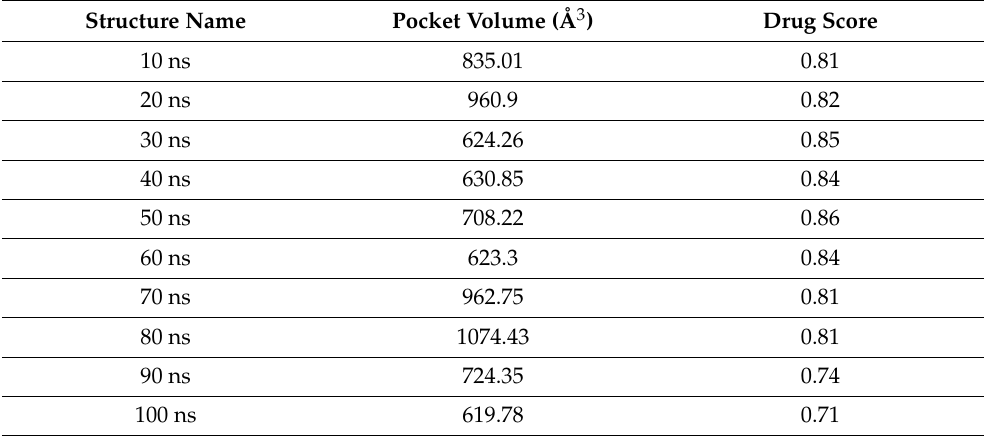
Table 1. Inspection of the binding site volume for 10 MD-derived protein structures in DoGSiteScorer. The calculation was performed with a grid-based method applying a Difference of Gaussian filter to detect the pockets. This incorporates size and shape descriptors, element descriptors, functional groups descriptors, amino acids composition, and amino acid descriptors [22,23].